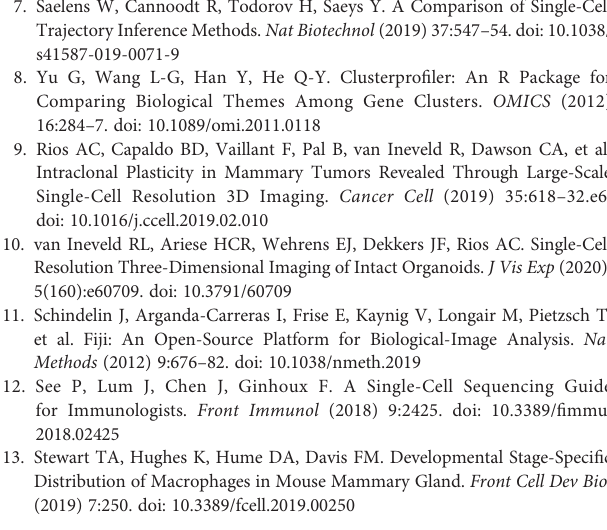
Supplementary Figure 1 | Comparison of the immune-cell composition of the lactating mammary gland with and without the inguinal lymph node. (A) UMAP plot of multiplex CD45 pos cells isolated from the lactating mammary gland from each of three mice (one including the inguinal lymph node). Cells indicate the assigned clusters. (B) Dot plot showing the average expression of the indicated genes and the percentage of cells within each cell cluster of the lactating mammary gland of mouse 2, which included the inguinal lymph node. The colors of the dots correspond to the average expression of the corresponding gene within each cell cluster. The size of each dot corresponds to the percentage of the cells expressing the gene within each cluster. (C) Proportion of CD45 pos immune cells in the lactating mammary gland of mouse 2, which included the inguinal lymph node, determined by scRNA-seq. The numbers indicate the percentage of each cell type among all immune CD45 pos cells. Supplementary Figure 2 | Automatic single-cell cluster annotation of lactating mammary gland immune cells using the clustifyr package and the following reference datasets: Mouse Cell Atlas (A) , Tabula Muris (B) . Supplementary Figure 3 | Dot plot showing the average expression of indicated genes and the percentage of cells within each cell cluster. The colors of the dots correspond to the average expression of the corresponding gene within each cell cluster. The size of each dot corresponds to the percentage of cells expressing the gene within each cluster. Supplementary Figure 4 | Trajectory inference of CD45 pos immune cells in the lactating mammary gland. The trajectory inference was performed using the Dyno package (slingshot model). In the left panel, the colors indicate the identi fi ed cluster after automatic assignation and in the right panel the inferred